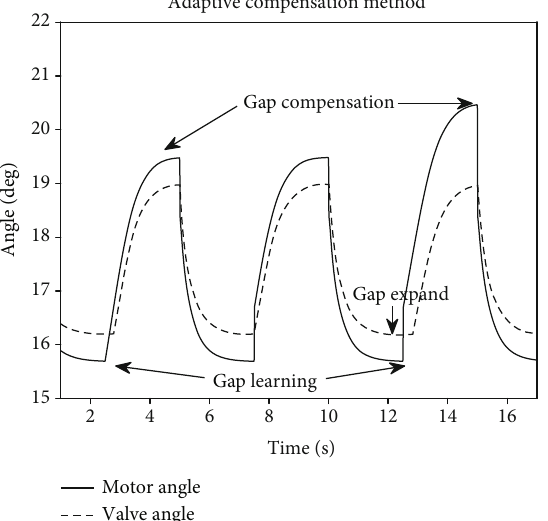
Figure 16: Simulation result of backlash compensation in an adaptive case (part I blowup).